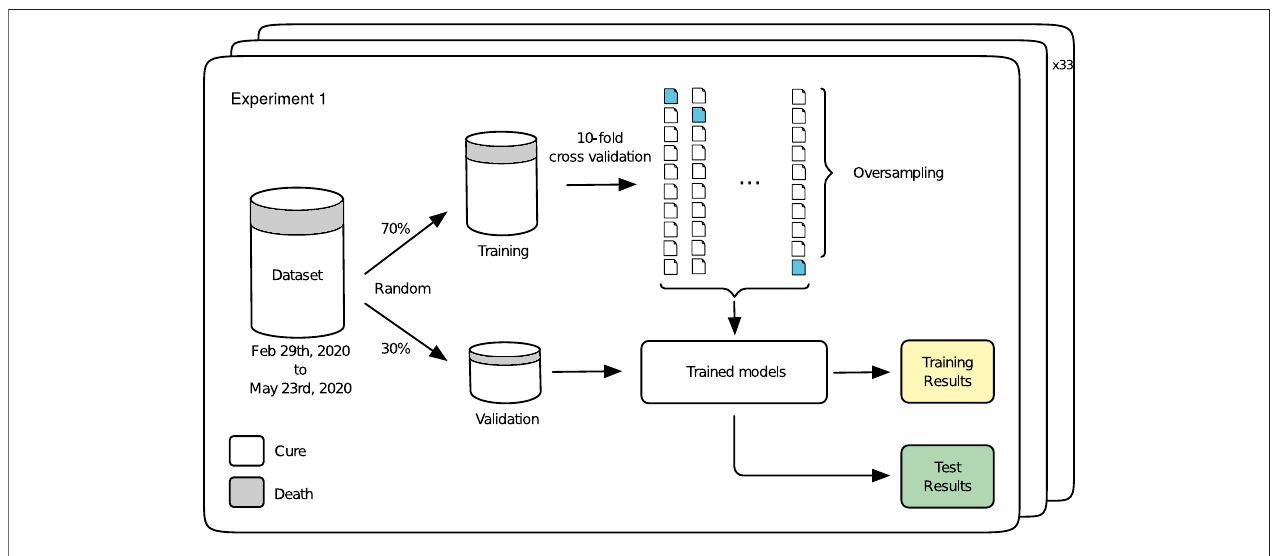
FIGURE 2 | Experiment